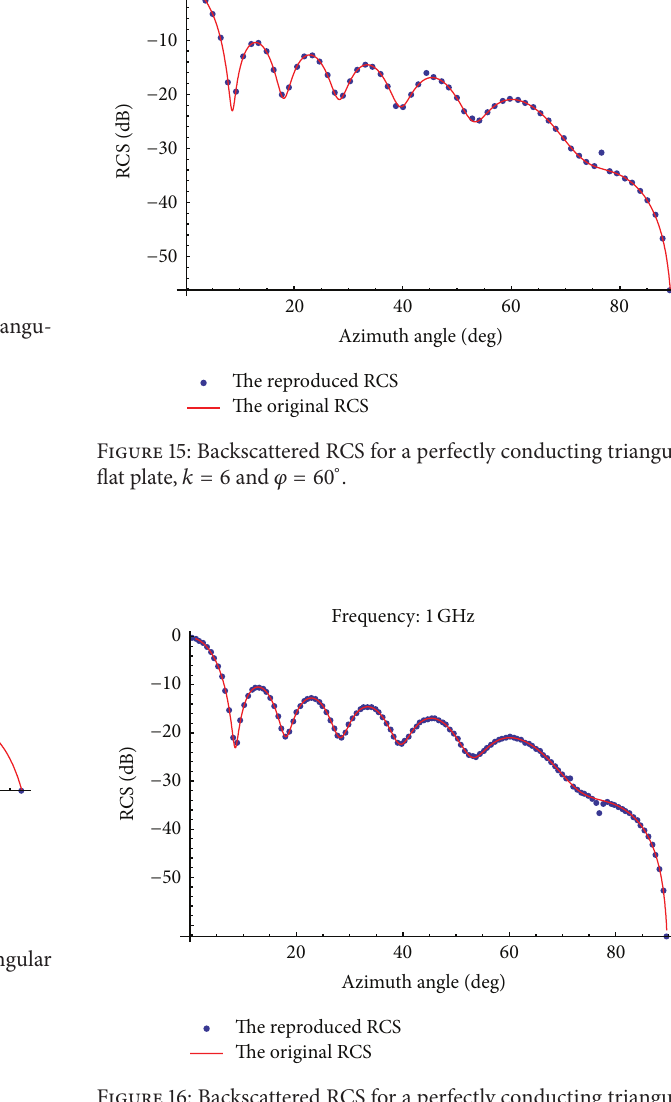
Figure 16: Backscattered RCS for a perfectly conducting triangular flat plate, 𝑘 = 7 and 𝜑 = 60 ∘